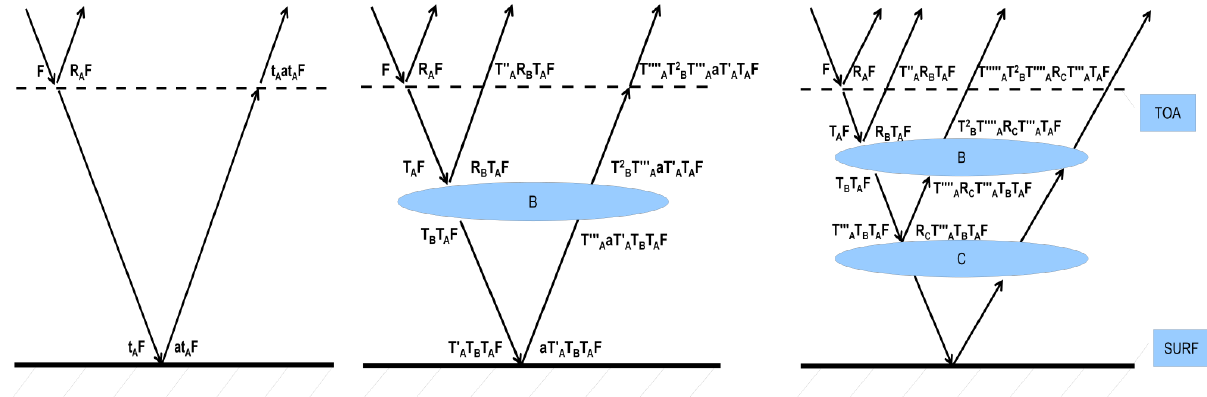
Fig. 1. Diagram of the computation of net fluxes at the top of the atmosphere (TOA) for completely clear sky (left) in the presence of an atmospheric agent “ B ” (centre) and in presence of two superposed atmospheric agents “ B ” and “ C ” (right). For ease of reading, at each interaction between the flux and an atmospheric agent, we indicate as the first factor the coefficient that describes the last modification of the flux. Here, t and T transmissivities for clear sky and with the presence of an atmospheric agent, respectively; R is the reflectivity; and a is the surface albedo. For a given atmospheric layer, T + R + A = 1 ( A = absorptivity). Transmissivity is related to the optical depth τ by the relation T = exp ( − τ)